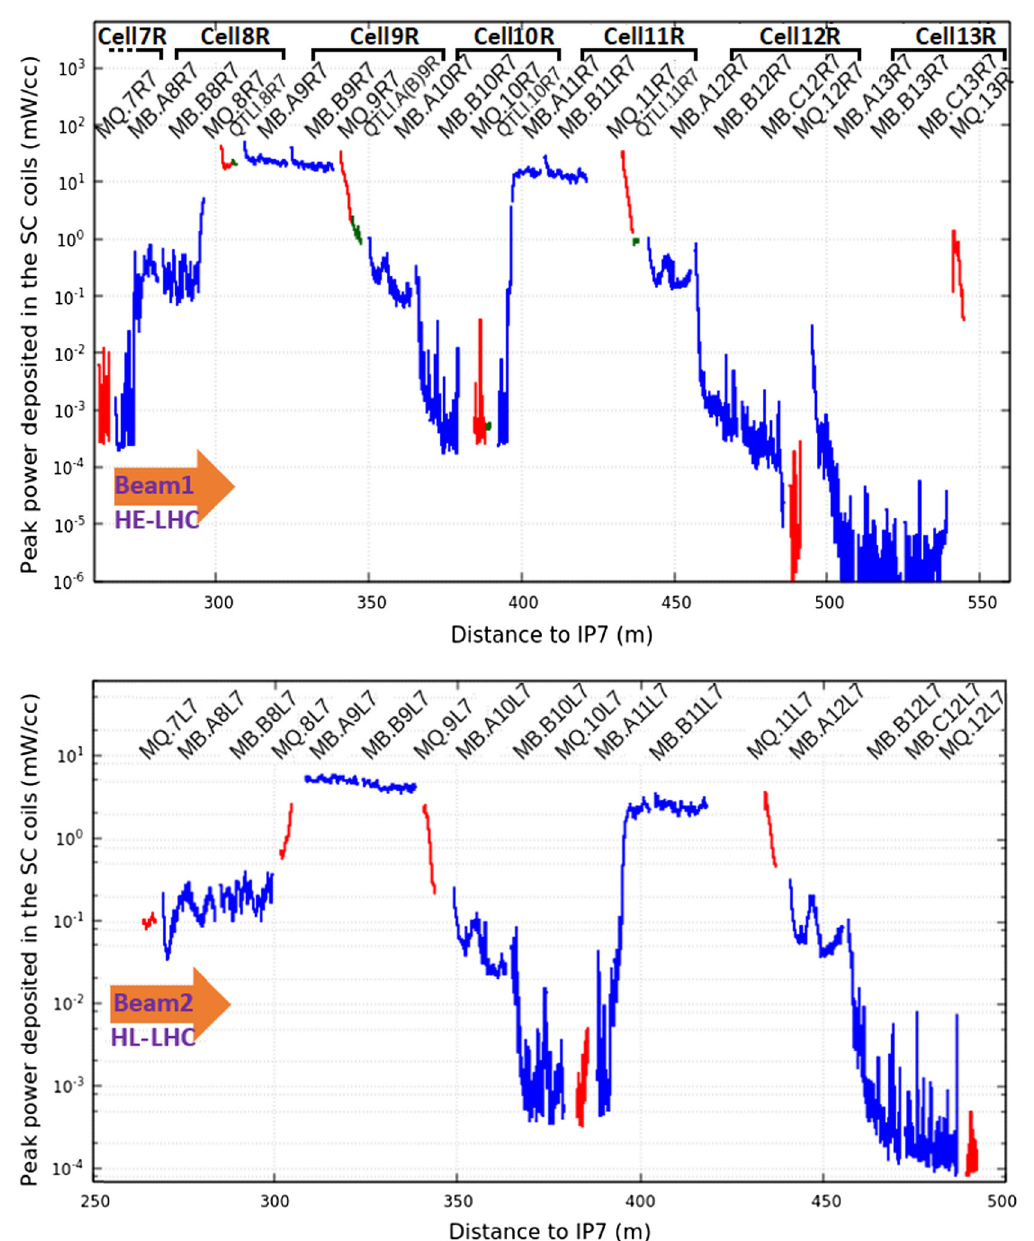
FIG. 11. Profile of peak power density in the SC coils along the IR7 cold magnets of HE-LHC (top) and HL-LHC (bottom) [38]. In the HE case, the TCLD collimators are kept fully open, while the HL case refers to the current layout, where the main dipole replacement — meant to accommodate the TCLD collimator — did not take place yet. Blue corresponds to the main dipoles, red to the main quadrupoles, and dark green to the trim quadrupoles. Values are calculated for 0.2 h BLT and are radially averaged over the SC cable